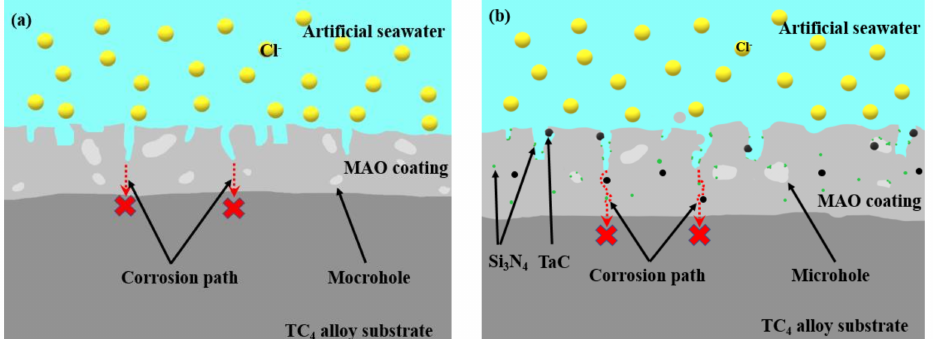
Figure 11. Corrosion resistance mechanism of the MAO coatings with and without Si 3 N 4 /TaC particles: ( a ) MAO coating without Si 3 N 4 /TaC particles; ( b ) MAO coating with Si 3 N 4 /TaC